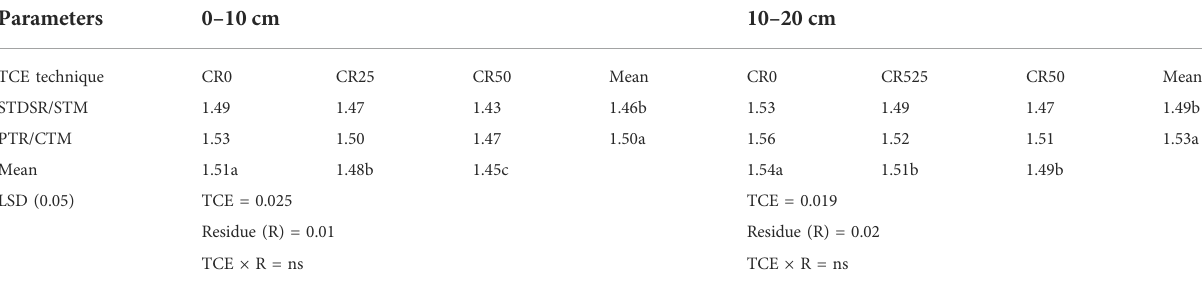
TABLE 3 Soil bulk density (Mg m − 3 ) at two soil depths under different tillage and crop establishment (TCE) techniques and residue management (R) options at the end of 2 years of the rice-maize system. Parameters